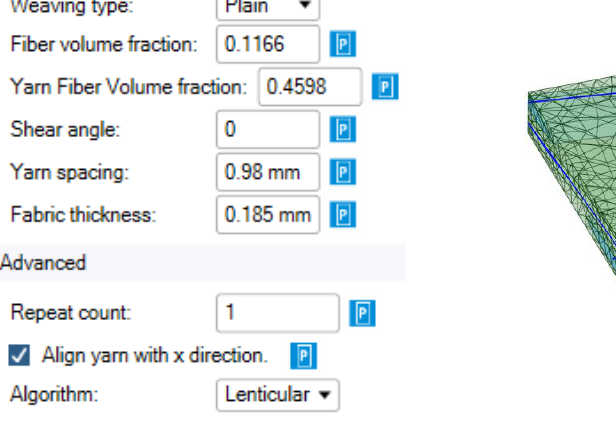
Figure 2. Initial data for constructing geometry, geometric and finite element RVE models. As follows from the help system [24], the Fiber volume fraction parameter is defined as the product of the Yarn volume fraction parameter by the Yarn fiber volume fraction parameter (see the transcription above). The Yarn volume fraction is not set directly,